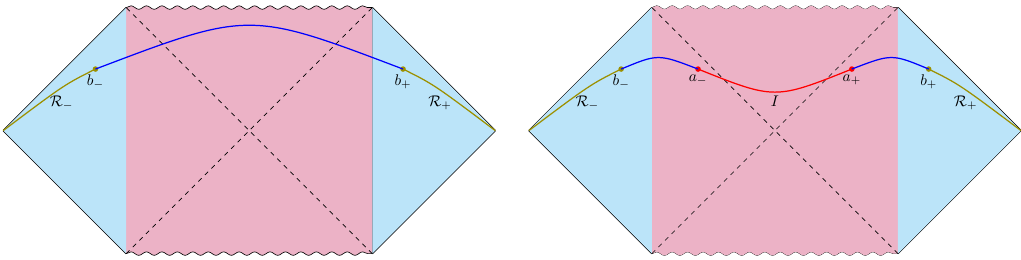
Figure 1 . The Penrose diagram of the HV black brane geometry which is shown in purple and two Minkowski spacetimes as the baths shown in cyan. ( Left ) when there are no islands. ( Right ) when there is an island I indicated in red with endpoints a and a . The radiation region is − + R = R + ∪ R − and indicated in olive. The endpoints of R are denoted by b ± and are located in the baths. We assume that the state on the full Cauchy slice is pure. Therefore, one can calculate the EE of matter fields S ( R ∪ I ) on the complement intervals [ b ] in the left panel and matter − , b + [ b ] ∪ [ a ] in the right panel which are shown in − , a − + , b +